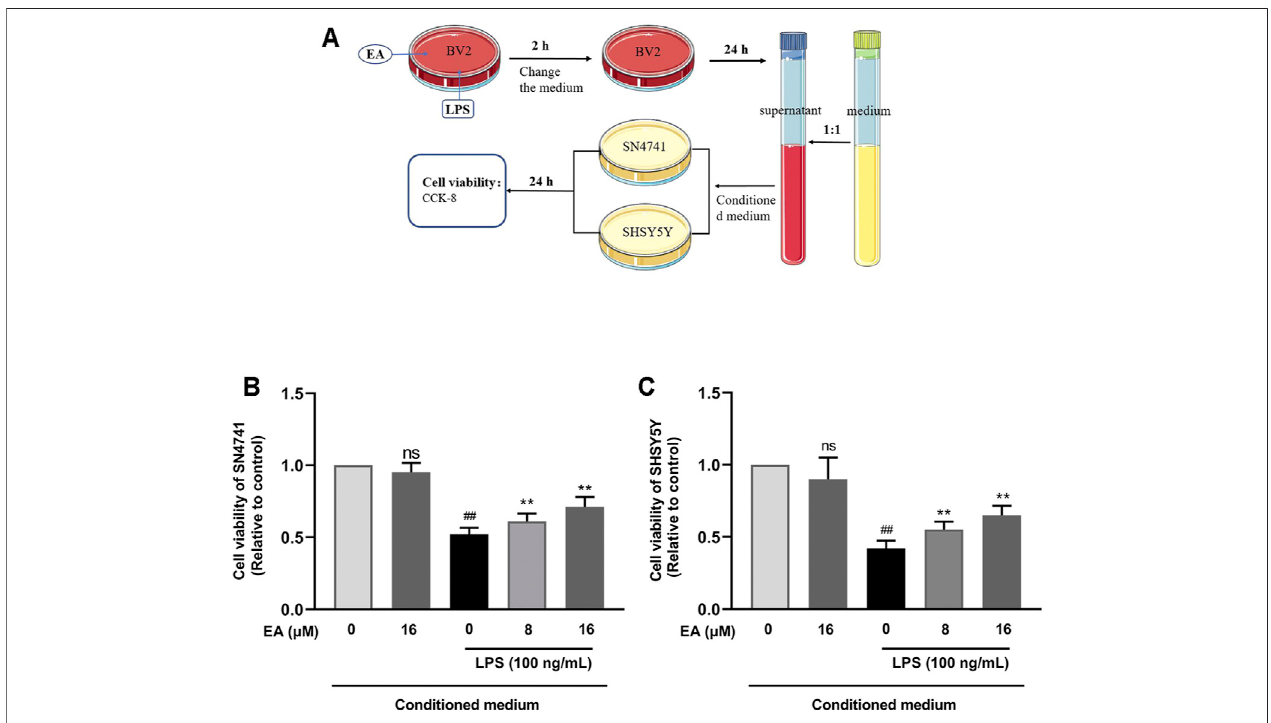
FIGURE5| EAeasesmicroglia-mediatedneurondeathinSN4741 cellsandSHSY5Ycells.WetreatedBV2cellswithEA(16 μ M)andLPS(100 ng/ml)for2 h,and then changed the medium. After 24 h, the medium was collected and mixed with the fresh medium in a 1:1 ratio as the conditioned medium (A) . Then the effect of the conditioned medium on the survival rate of SN4741 cells (B) and SHSY5Y cells (C) was detected by CCK8 experiment. Results are represented as means ± SD ( n (cid:1) 4). ## p < 0.01 vs. control group. **p < 0.01 vs. LPS-exposed group.